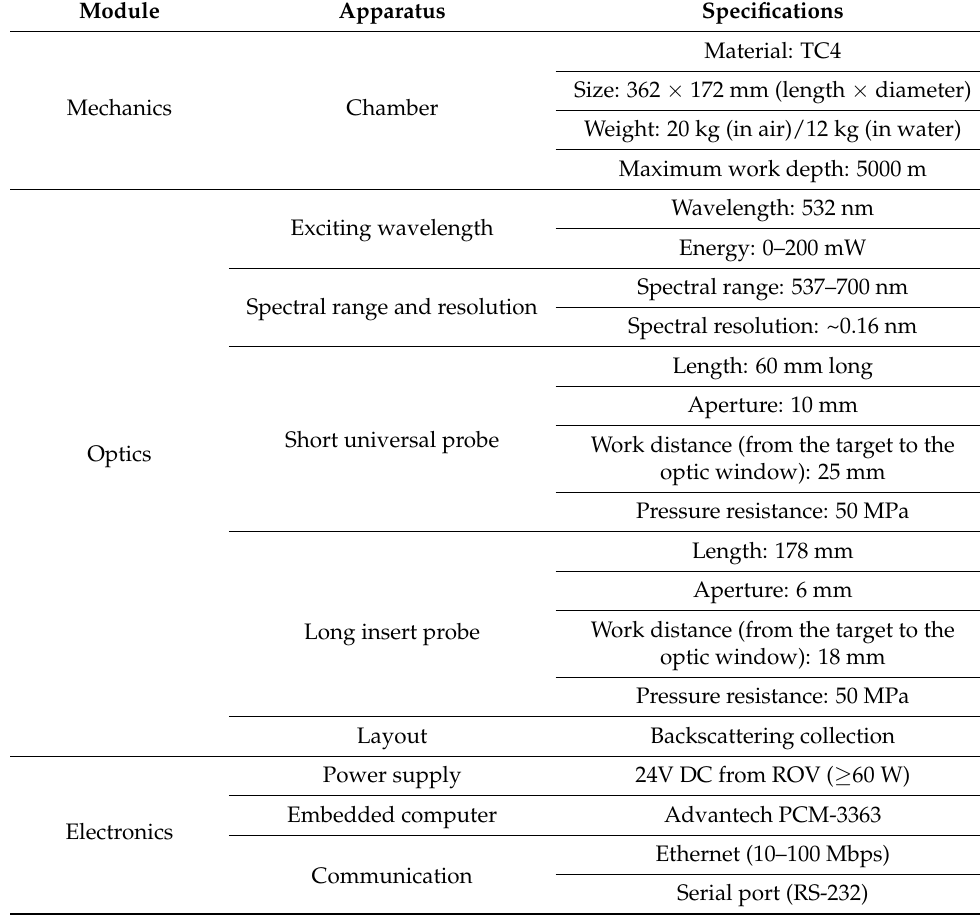
Table 1. Specification of the easy-to-operate Raman